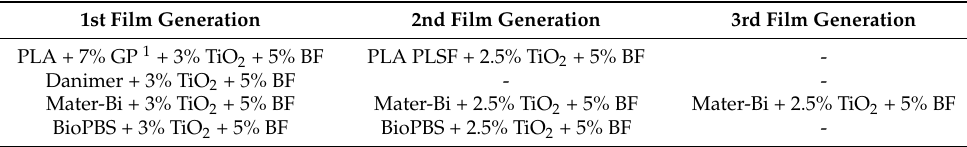
Table 5. Compounding for each generation of